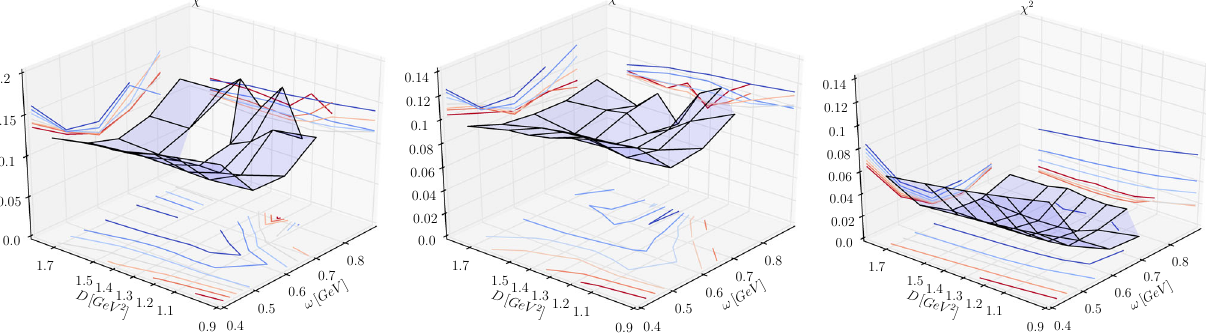
Fig. 18 χ 2 plot from the comparison of our calculated and the experimental orbital splitting as a function of ω and D . Left panel Combination of all orbital splittings (see text); center panel combination of a subset of five splittings (see text); right panel ( [ 1 +−